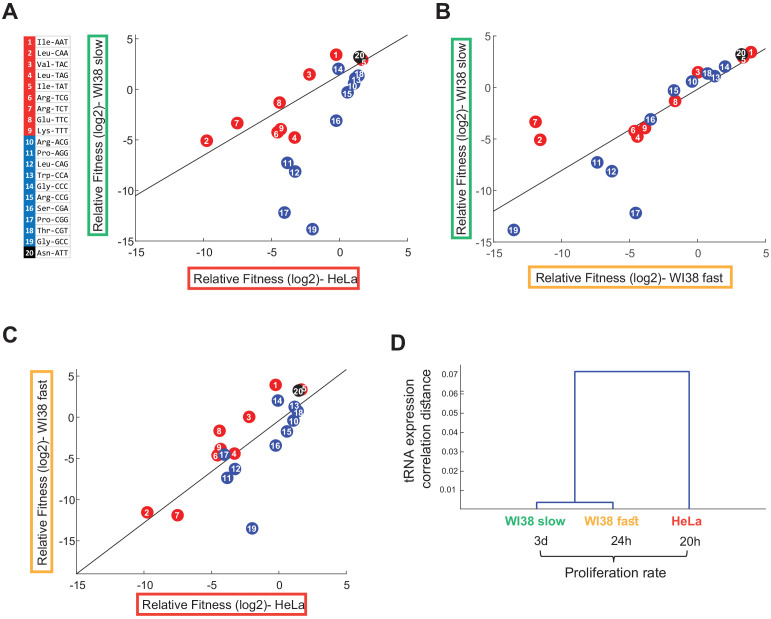
The tRNA essentiality depends on cell line origin and the proliferation rate.(A-C) Scatter plots that indicate the correlation between the relative fitness (log2) of the edited tRNA cells between all pairwise combinations of three cell lines (Person correlation, (A) HeLa vs WI38 Slow: r = 0.54, p<0.05; (B) WI38 Fast vs WI38 Slow: r = 0.81, p<10−4; (C) HeLa vs WI38 Fast: r = 0.76, p<10−4). The relative fitness of each CRISPR-targeted tRNA variant in each cell lines was determined based on day 7 of the cell competition, and was averaged over two biological repeats. (D) Hierarchical clustering of the tested cell lines based on the tRNA pool expression in WT cells.